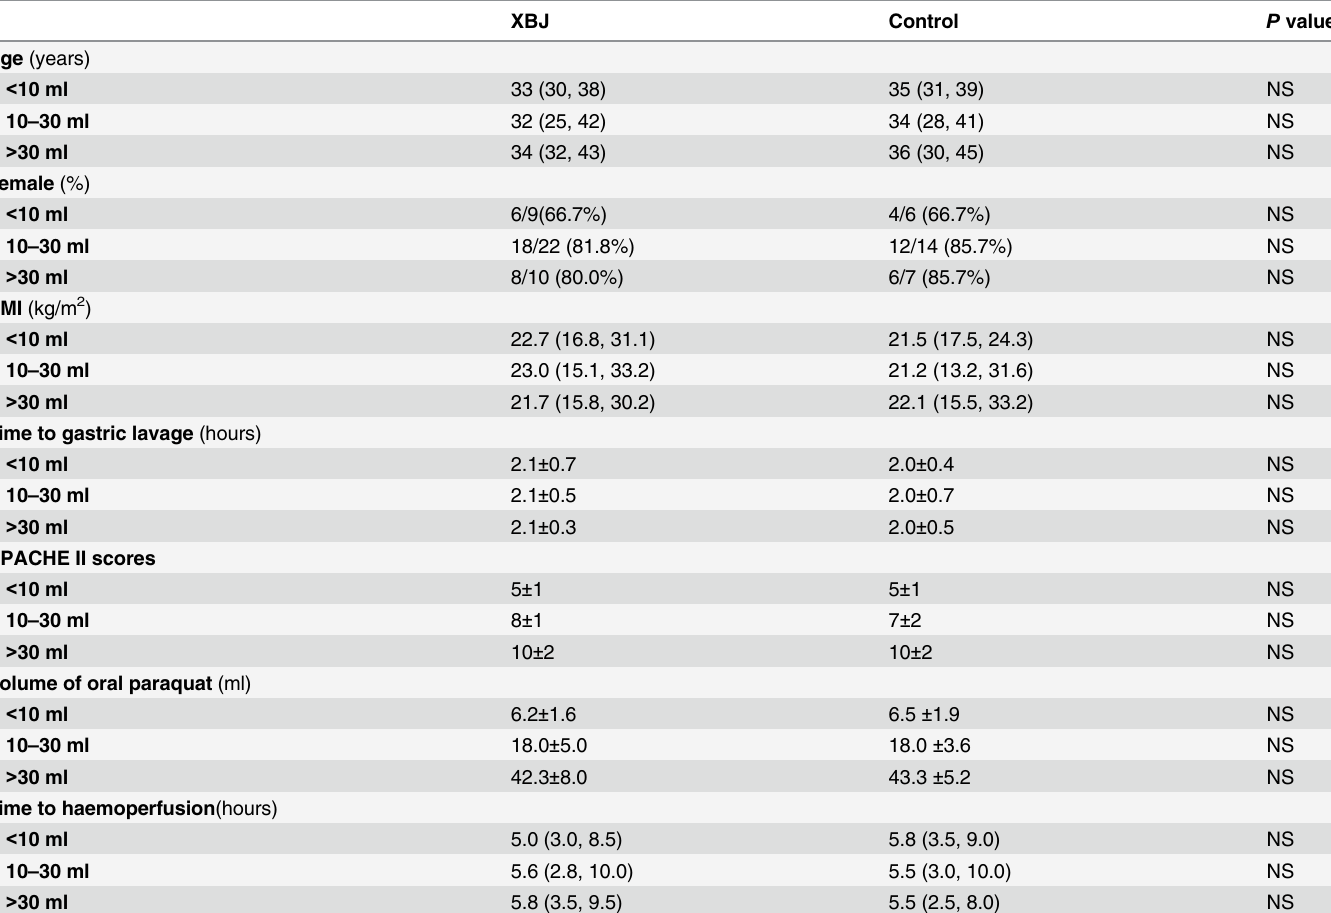
Table 1. Baseline characteristics.